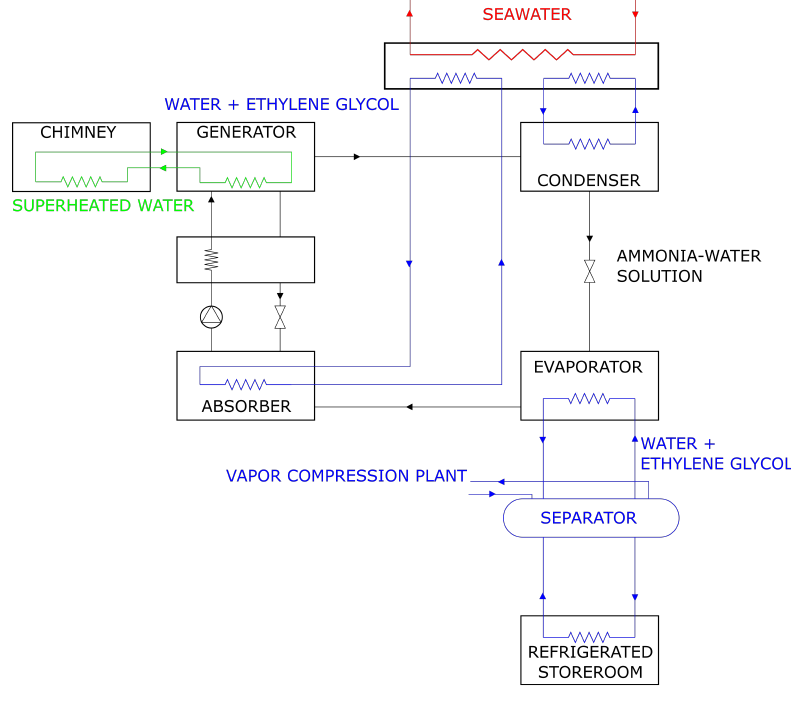
Figure 6. Scheme of the refrigeration